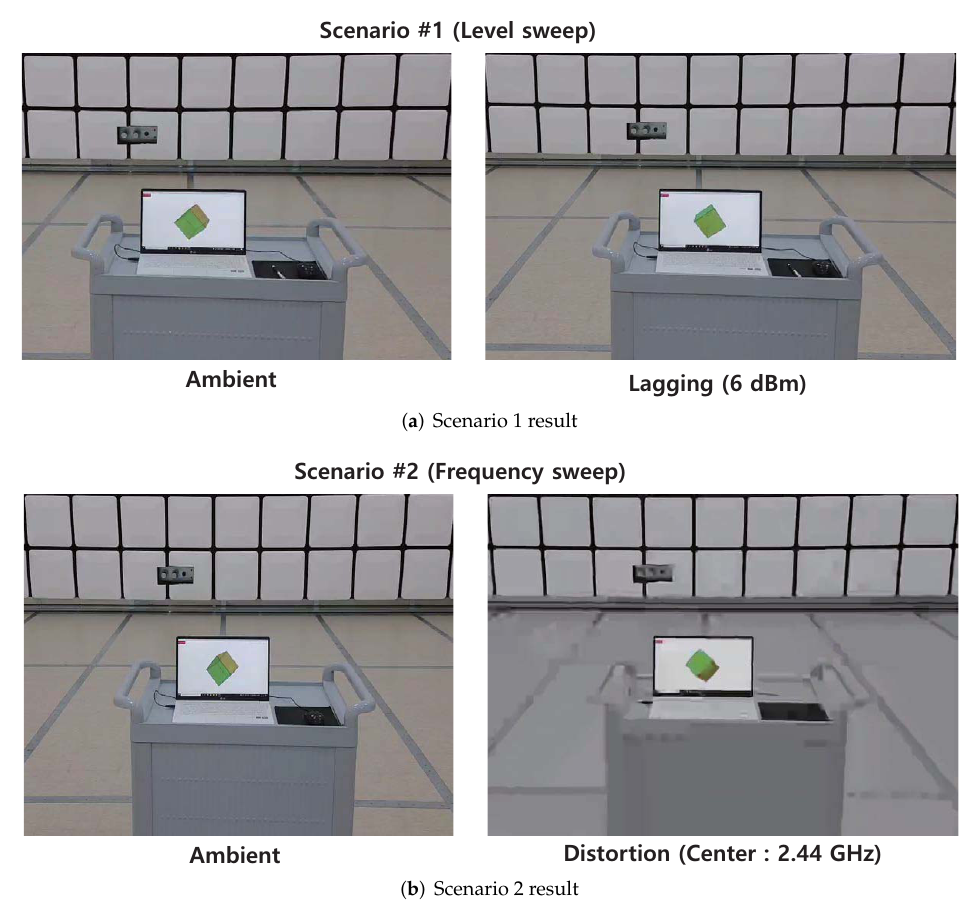
Figure 11. Results of low-power IEMI on camera module using digital communication scheme. The video status changed for Scenario 1 and Scenario 2. ( a ) Lagging occurred when the attack signal level exceeded 6 dBm. Distortions were not observed. ( b ) Distortion occurred when the attack signal overlapped with the video transmission channel. When the attack signal exceeded the channel frequency, the video quality was